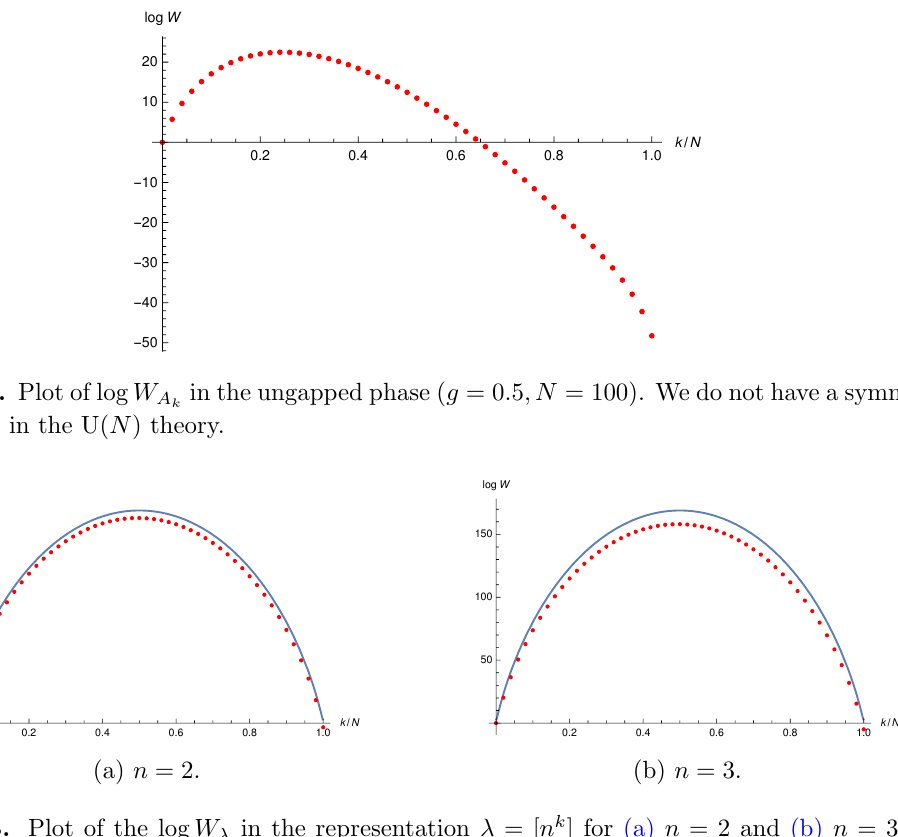
, while the solid curves [ n k ]